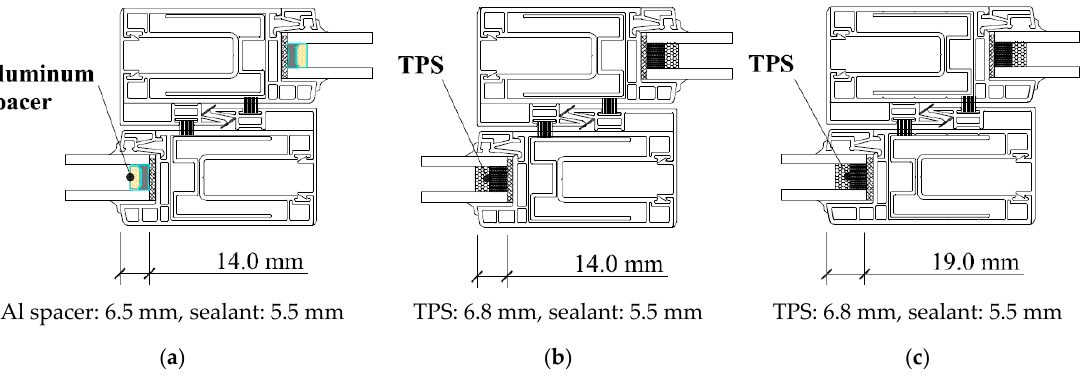
Figure 4. Horizontal cross section of the inner meeting rail for each case: ( a ) Case 1; ( b ) Case 2; ( c ) Case 3.